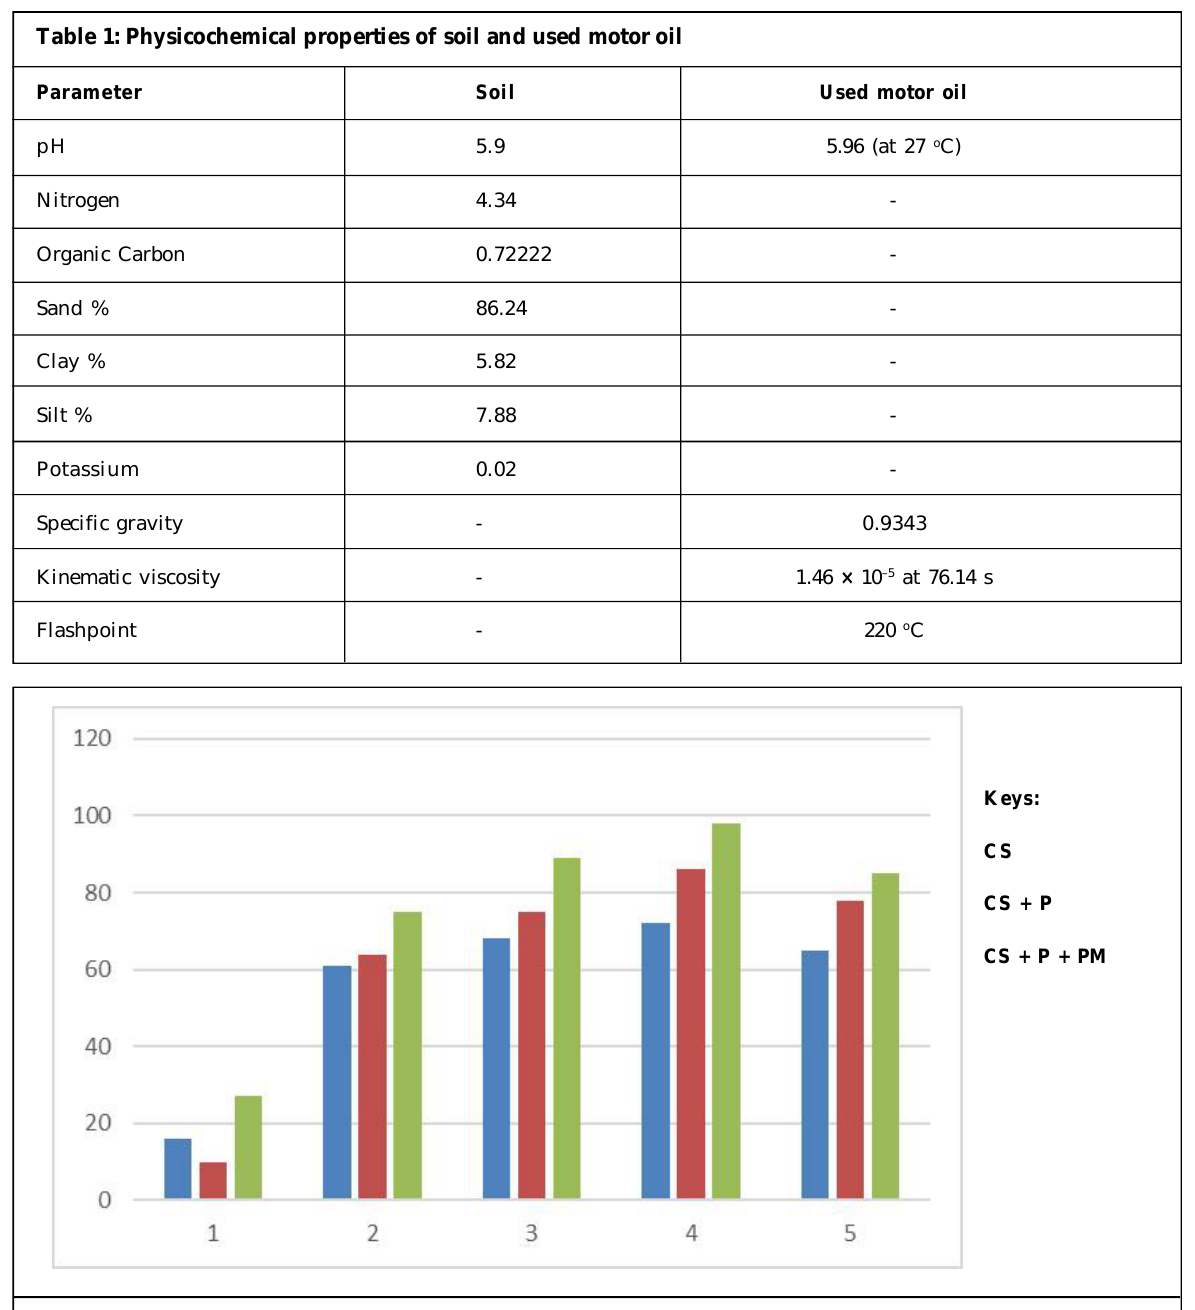
Figure 1: Counts of heterotrophic bacteria population in soil polluted with used motor